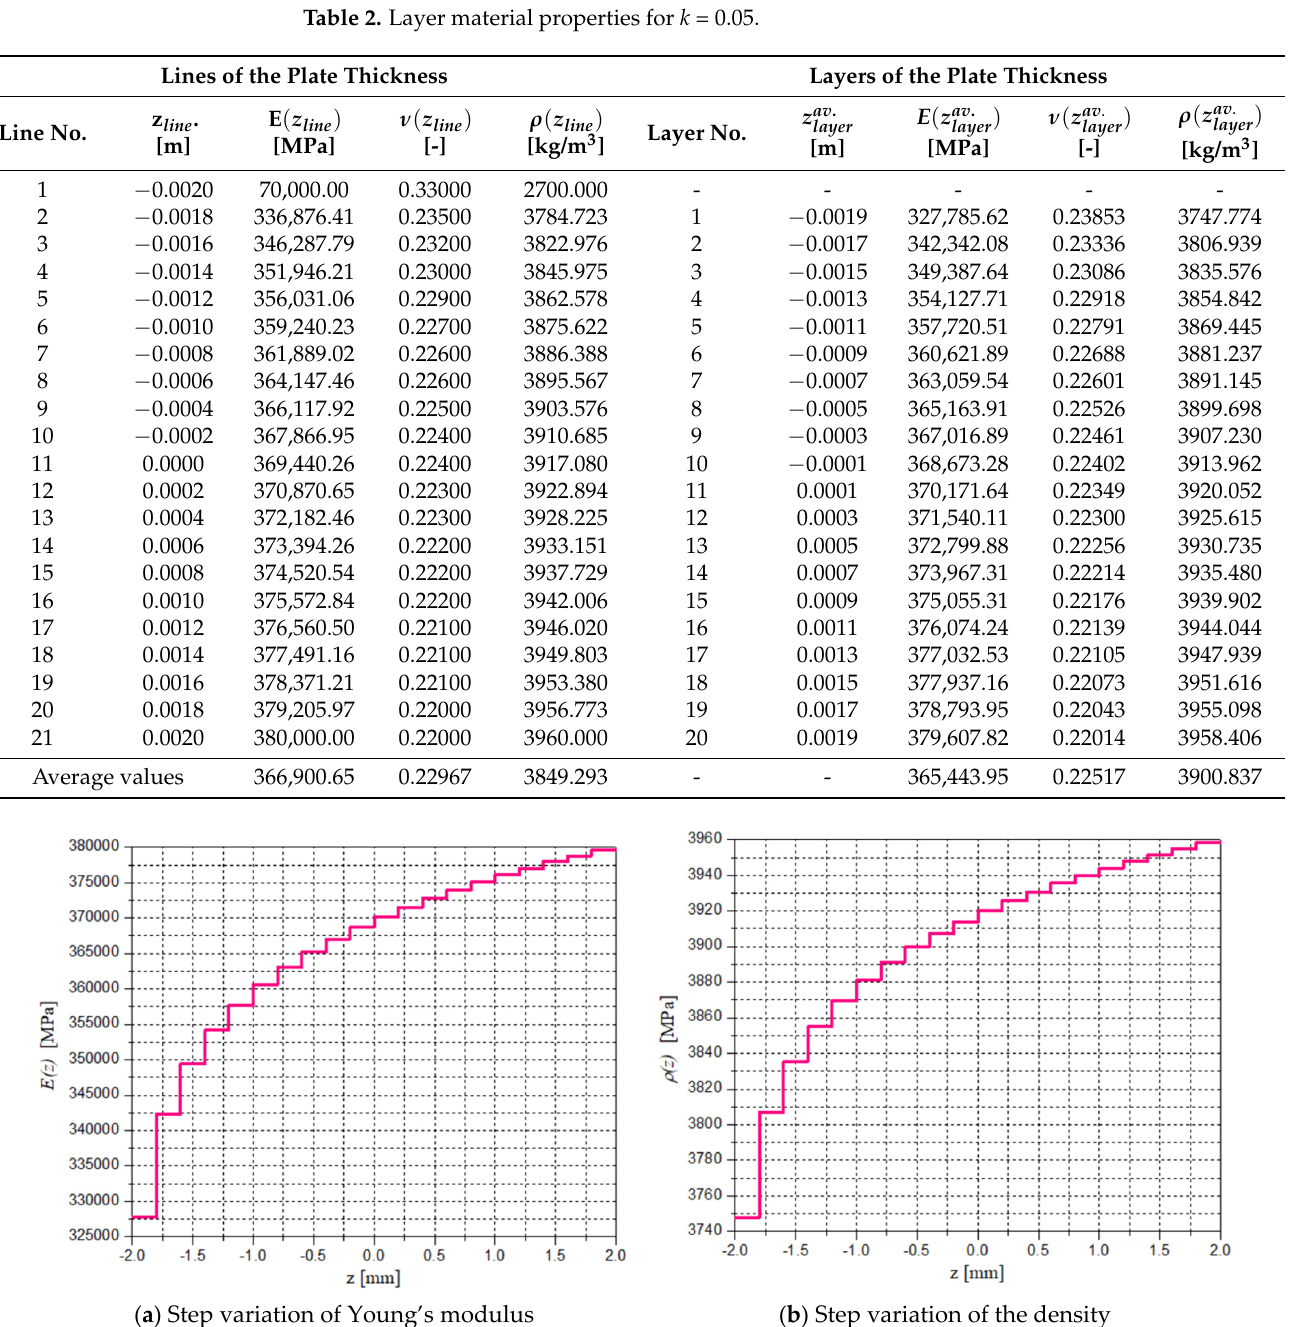
Figure 7. Variation curves of some material properties, ( a ) Young’s modulus, ( b ) density. In Table 3, the values of Young’s modulus are presented, for the FGP model, with 20 layers and different values of the power coefficient k , according to the methodology pre-